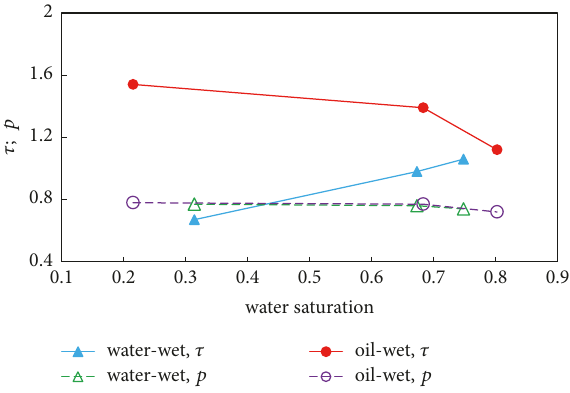
Figure 7: Exponent change of the power-law distributions of oil clusters during the water